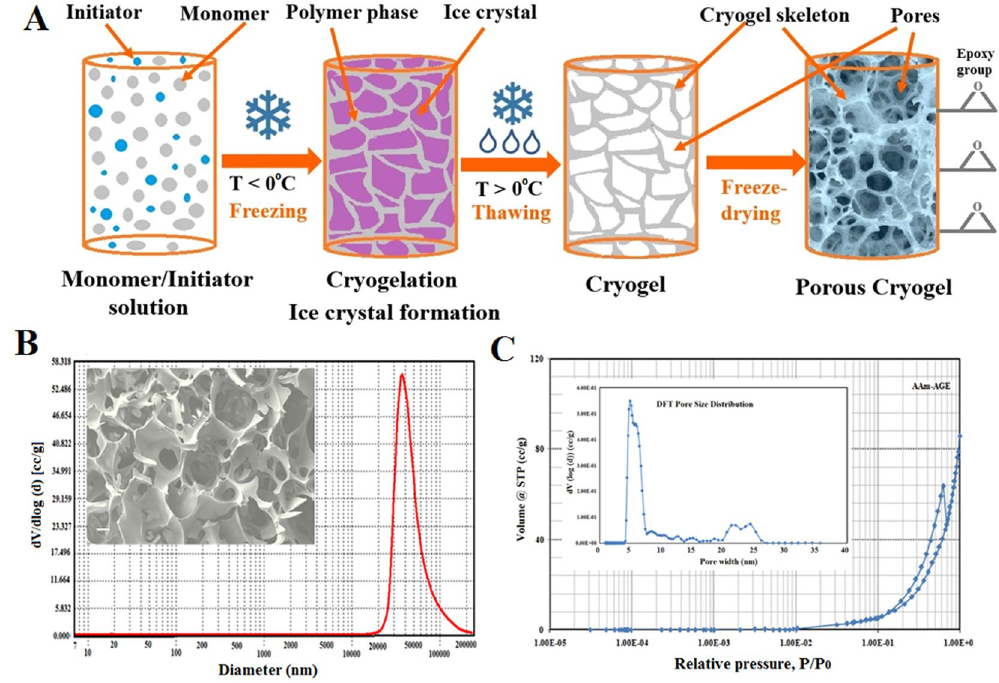
Figure 1. The process of cryogel formation and macro-meso pore size distribution. ( A ) The different stages that occur during cryogelation. ( B ) Macropore size distribution as determined by mercury porosimetry and inset SEM images showing internal porous architecture, Scale bar = 20 μ m. ( C ) N 2 adsorption isotherm with inset image representing mesopore size